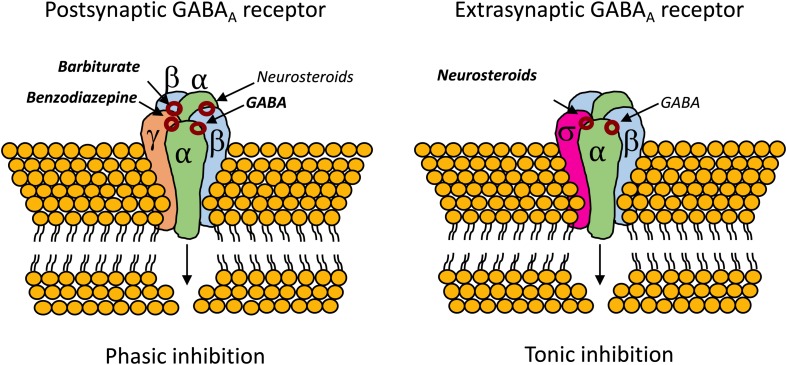
Binding sites for neurosteroids on the postsynaptic and extrasynaptic GABAAR (Reddy, 2011; Cai et al., 2018). Contrary to benzodiazepines, which require the mandatory γ subunit, neurosteroids can act on GABAAR whenever they are composed by α subunits (Bianchi and Macdonald, 2003). The extrasynaptic GABAAR usually contains the highly neurosteroid sensitive δ subunit, which opens an exploitable therapeutic window, especially in cases of benzodiazepine tolerance (Brown et al., 2002; Uusi-Oukari and Korpi, 2010; Meera et al., 2011; Rogawski et al., 2013; Carver and Reddy, 2016).